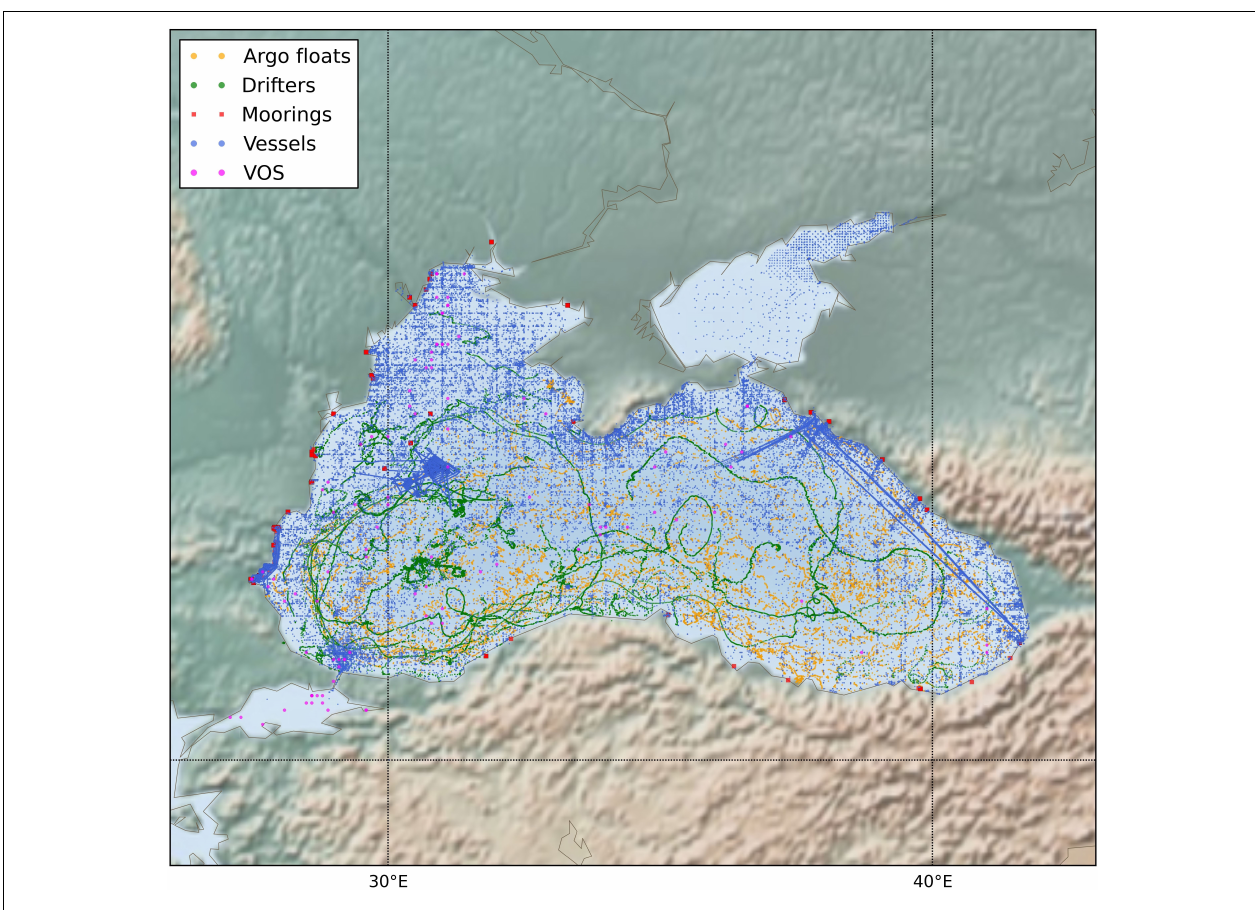
FIGURE 1 | Black Sea in situ data sources